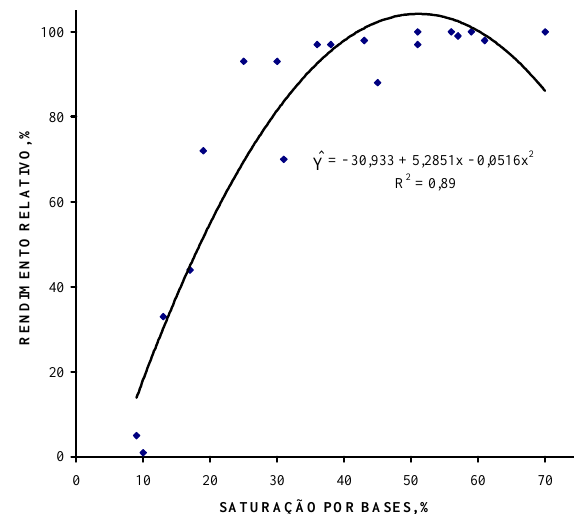
Figura 1. Relação entre o rendimento relativo de quatro cultivos de milho e a saturação por bases de um solo Glei Pouco Húmico. Dados de dezenove pares, médias de quatro repetições.